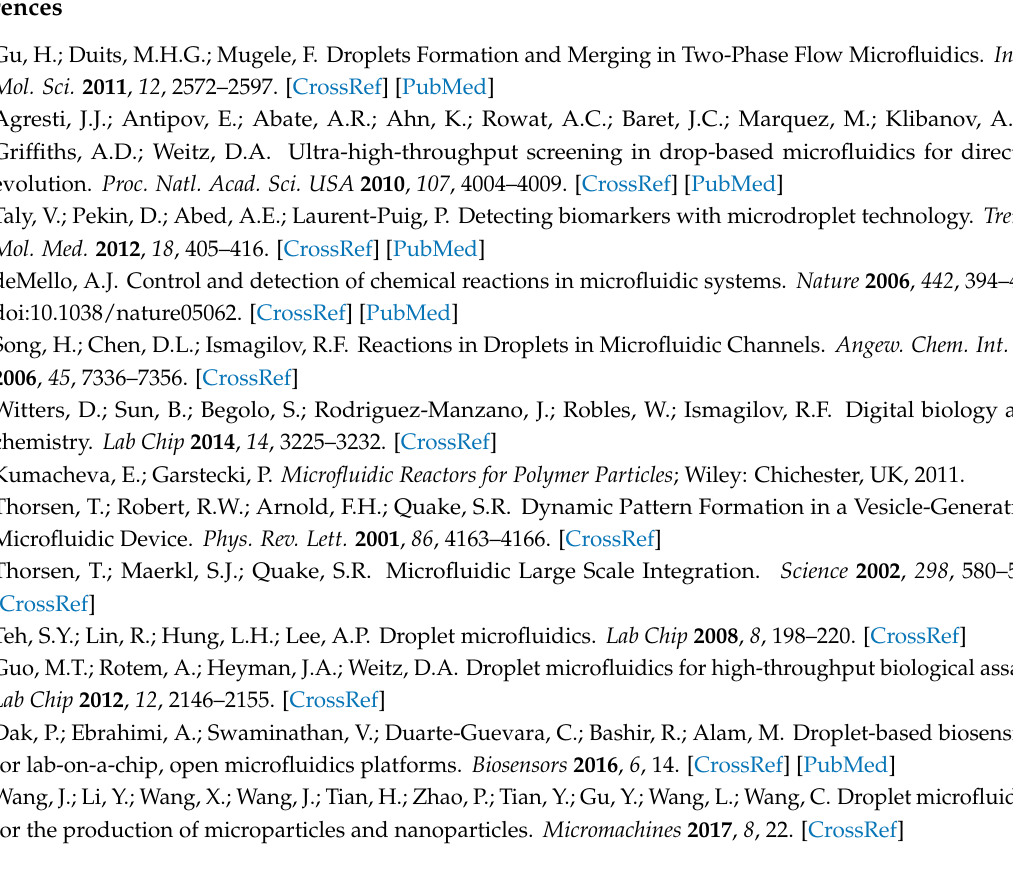
Figure S1: Chemical synthesis procedure of KryAz600 surfactant